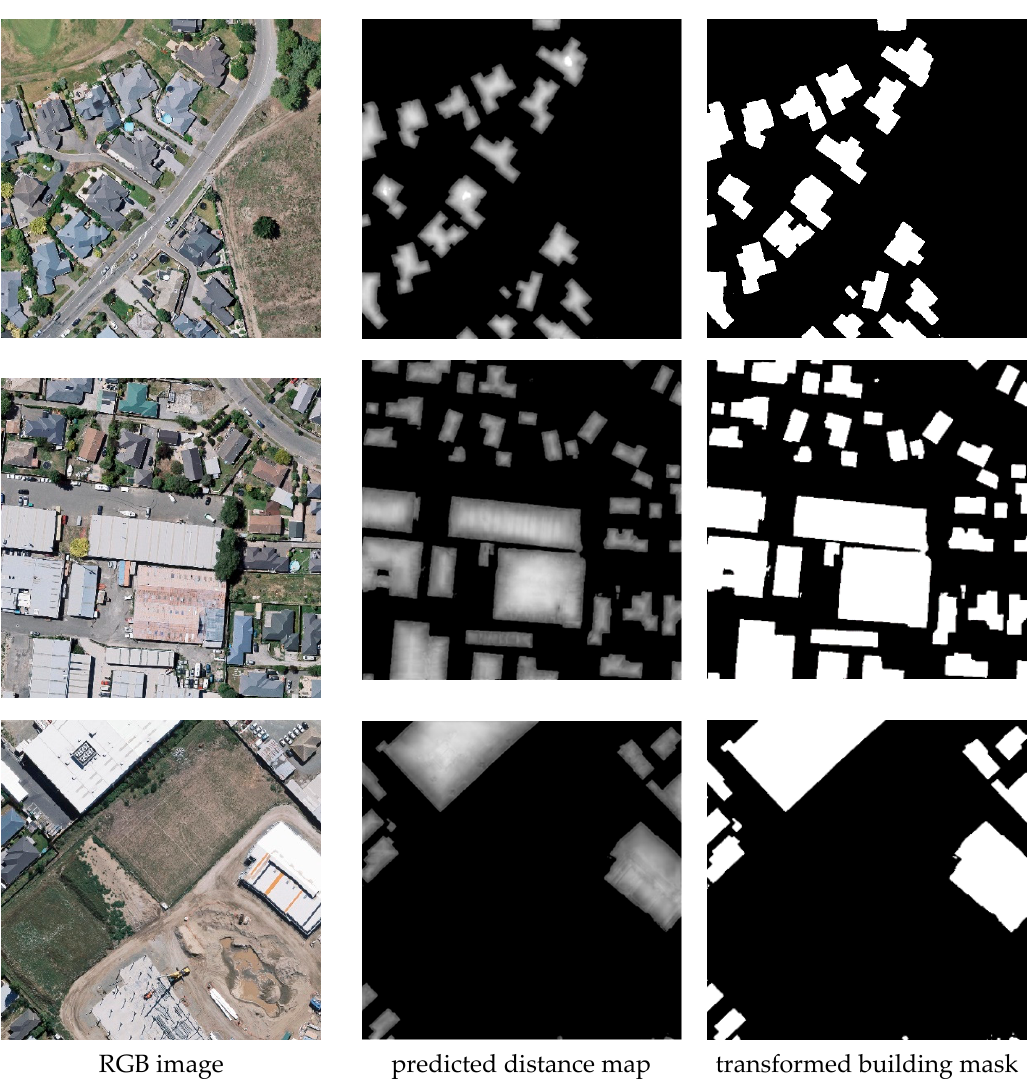
Figure 4. Examples of predicted distance maps and corresponding transformed building masks via the D → M transforming layer (i.e., f d → m ( x ) ).